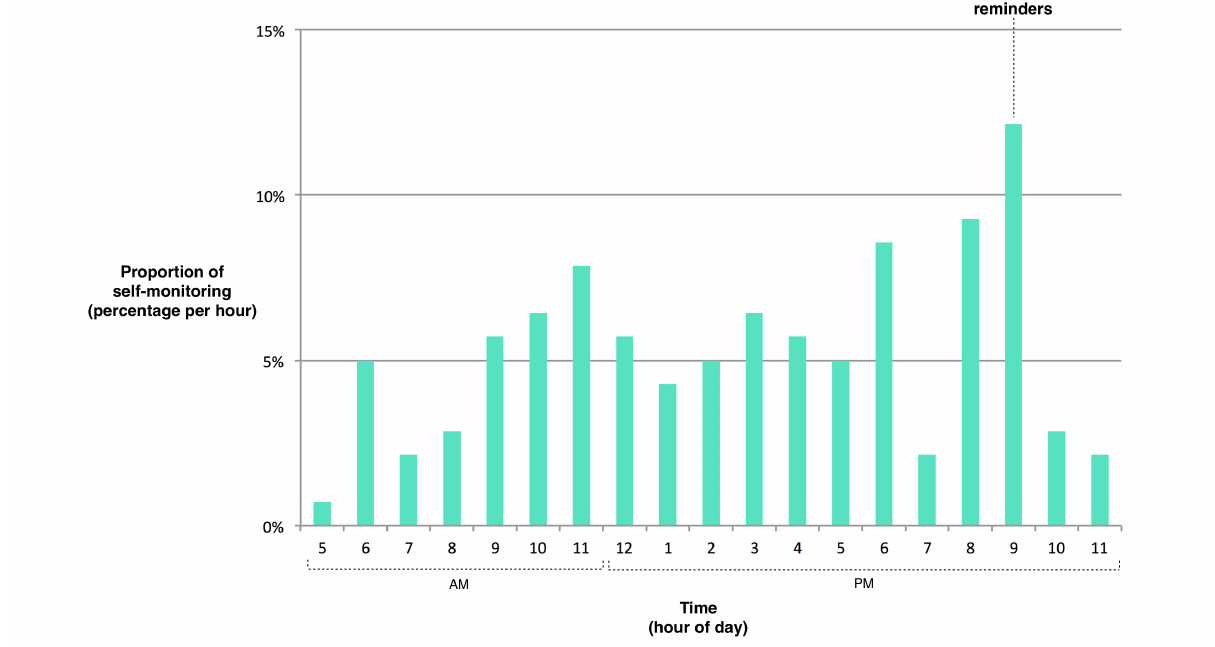
Figure 3. Time of day that users recorded their vegetable consumption using Vegethon. Each hour represents the subsequent 1-hour interval (eg, 5 represents 5:00-5:59 AM). Push notifications were sent at 9 PM as reminders to those who logged the day before but had not yet logged that